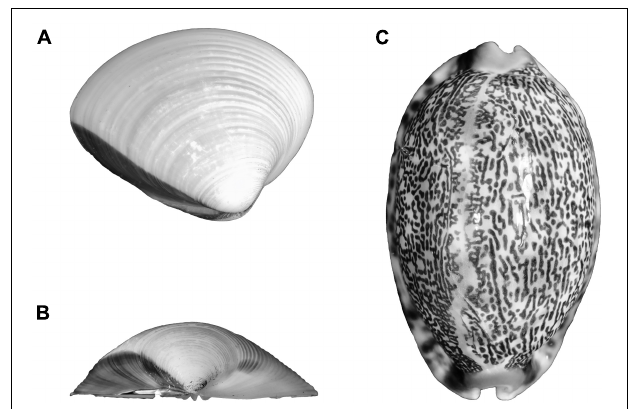
FIGURE 7 | (A,B) Bivalve ( Metrix metrix ) and (C) gastropod ( Cypraes arabica ) shells.